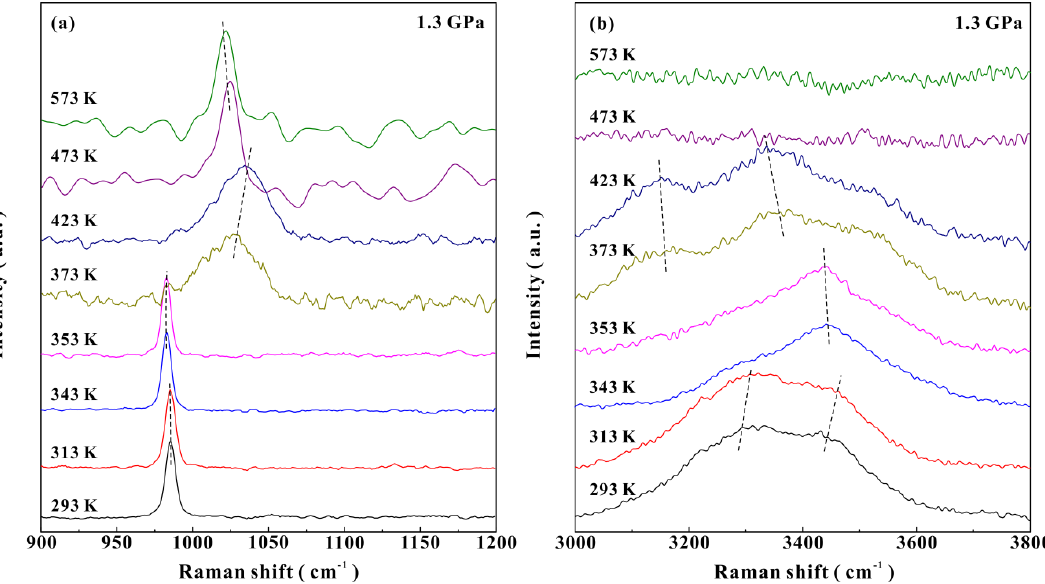
Figure 4. ( a ) The temperature-dependent Raman spectra of the epsomite at ~1.3 GPa for the sulfate Figure 4. (a) The temperature ‐ dependent Raman spectra of the epsomite at ~1.3 GPa for the sulfate internal vibration; ( b ) the high ‐ temperature Raman spectra of the epsomite at ~1.3 GPa for the internal vibration; ( b ) the high-temperature Raman spectra of the epsomite at ~1.3 GPa for the hydroxyl ‐ stretching vibration. hydroxyl-stretching